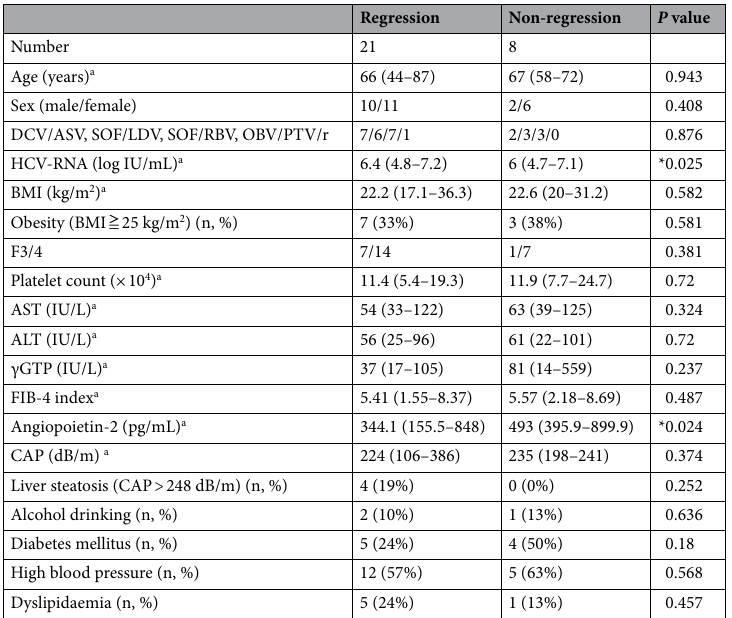
Table 3. Factors associated with non-regression of liver fibrosis stage based on LSM between baseline and SVR96 in HCV-infected patients with baseline advanced liver fibrosis, who were treated with DAAs. HCV hepatitis C virus, BMI body mass index, AST aspartate aminotransferase, ALT alanine aminotransferase, γGTP γ-glutamyl transpeptidase, FIB-4 fibrosis 4, CAP Controlled Attenuation Parameter. a Data are shown as median (range) values. *Statistically significant difference, P < 0.05.